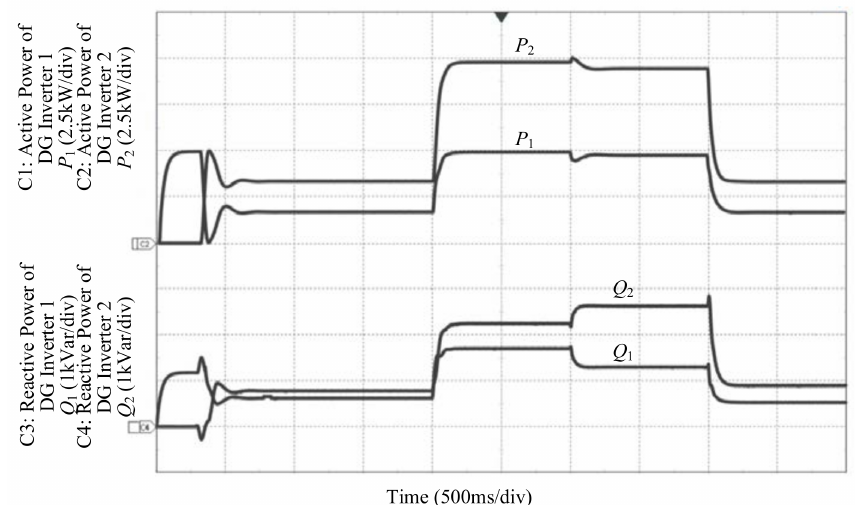
Figure 9. Variations of active and reactive power of the paralleled DG inverters with and without the proposed adaptive virtual inductance control